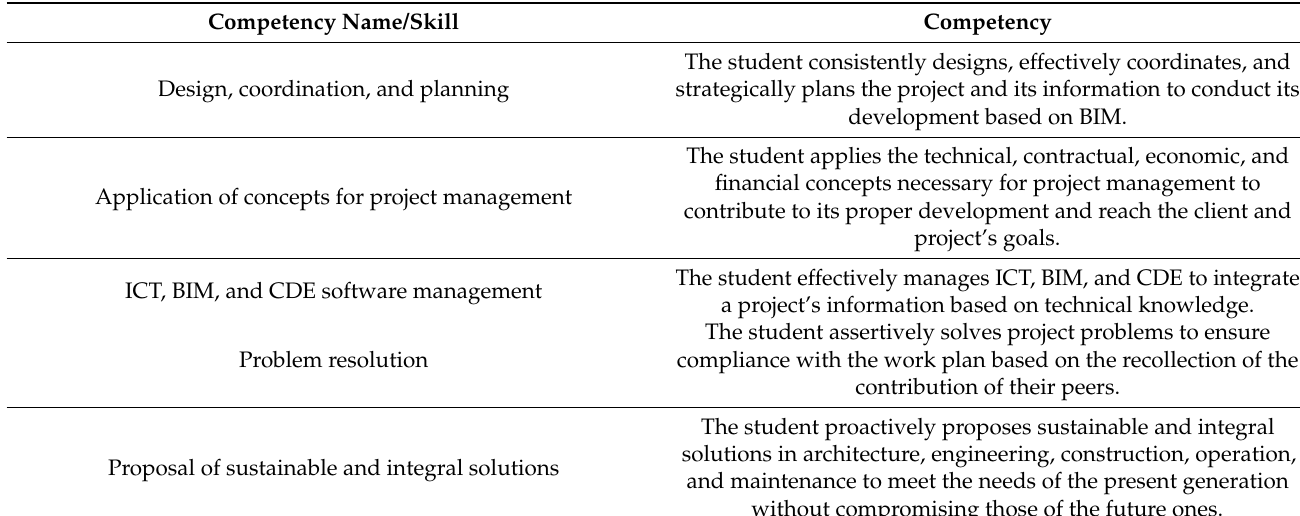
Table 4. Formulated BIM-specific competencies from the graduation